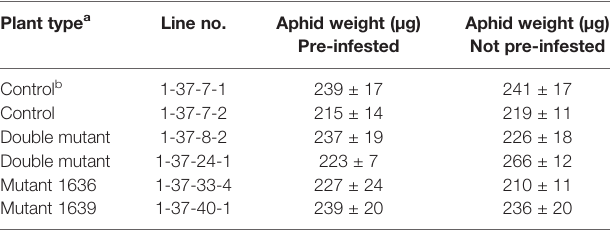
TABLE 3 | Rhopalosiphum padi individual weight (mean ± SE, n=6) after 4 d of growth on the test plants that had been either pre-infested with 20 aphids (all aphids removed after 3 d) or without